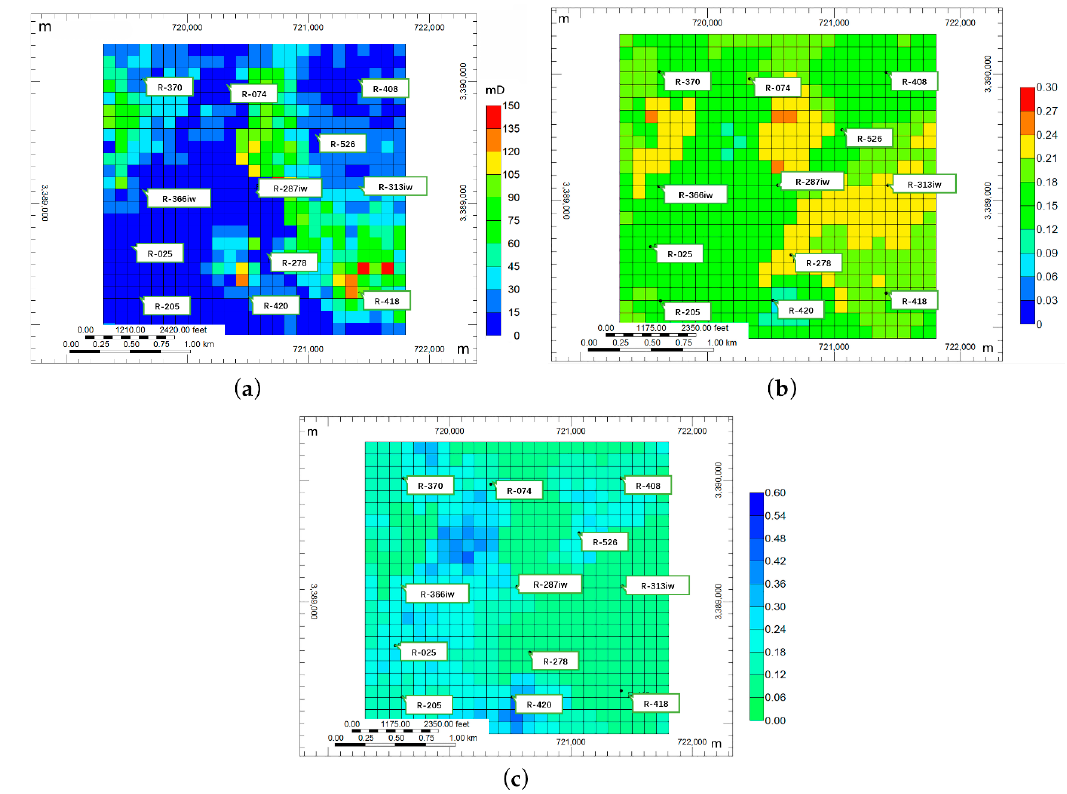
Figure 2. Reservoir properties of a representative layer in target reservoir in X-Y plane: ( a ) Permeability distribution of 22nd layer in X-Y plane; ( b ) Porosity distribution of 22nd layer in X-Y plane; ( c ) Initial water distribution of 22nd layer in X-Y plane.